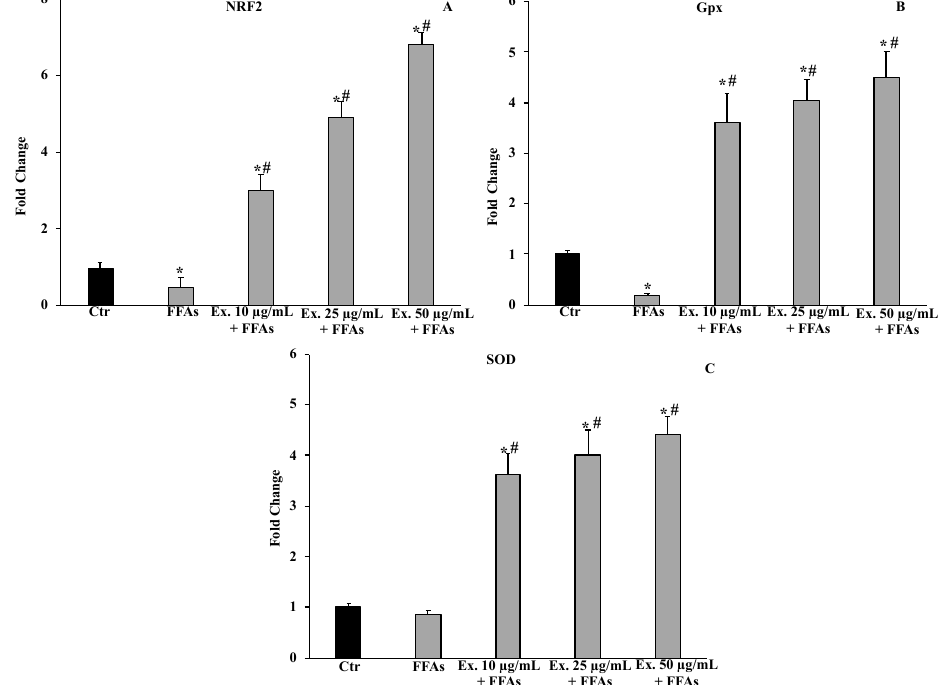
Figure 6. Effects of Cynara sylvestris extract pretreatment (10–25–50 µ g/mL) for 24 h on mRNA expression levels of oxidative stress related genes: Nrf2 (nuclear factor erythroid 2–related factor 2) ( A ), Gpx (Glutathione peroxidase) ( B ), and SOD1 (Superoxide dismutase) ( C ). The data are reported as the mean ± S.D. of three independent experiments in triplicate. * Significant vs. untreated control cells p < 0.001. # Significant vs. FFAs, p < 0.001.